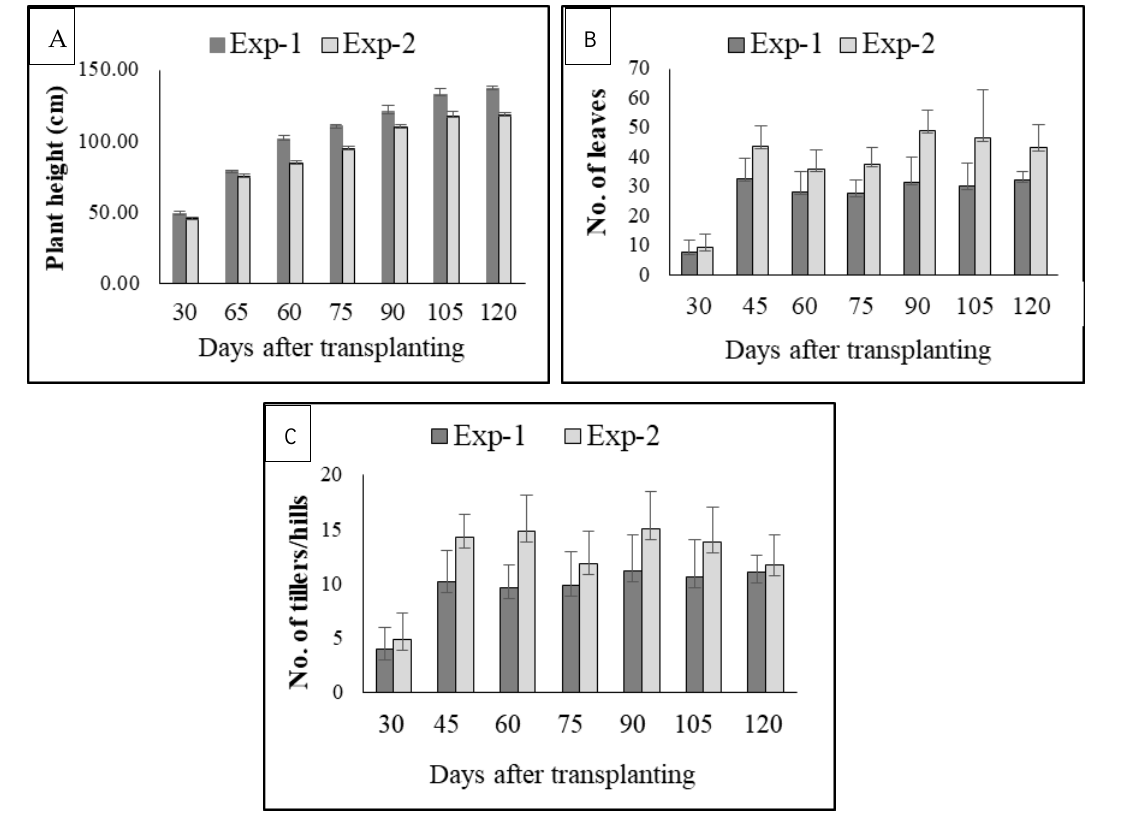
Figure 3. Rice growth parameters as characterized by ( A ). plant height, ( B ). no. of leaves and ( C ). no. of tillers/ hills in experiment-1 and 2 of a rice – fish – vegetable culture system. Values are means ± SD.